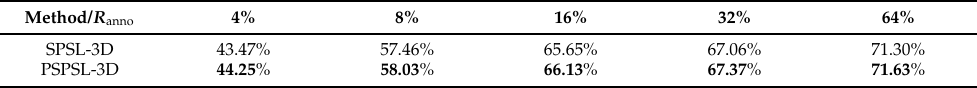
Table 8. 3D recall rate with an IoU threshold of 0.7 in the KITTI validation dataset.